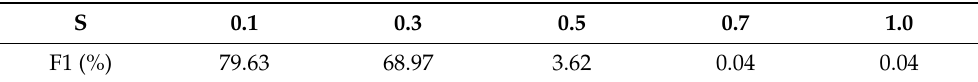
Table 5. LTA algorithm tuning. F1 index vs. S . The Sensitivity varies along the columns from 0.1 to 1.0.